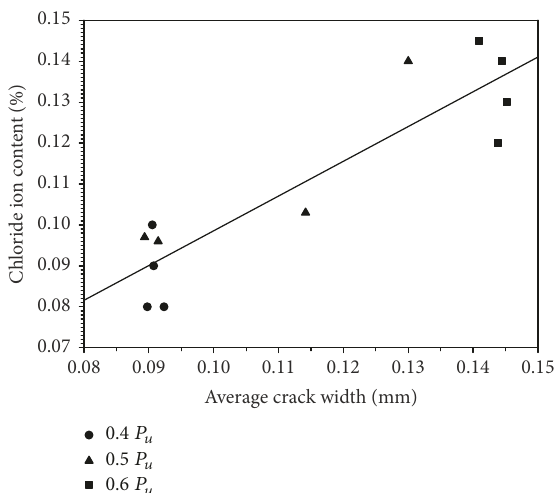
Figure 7: Relationship between chloride content at steel surface and average crack width.